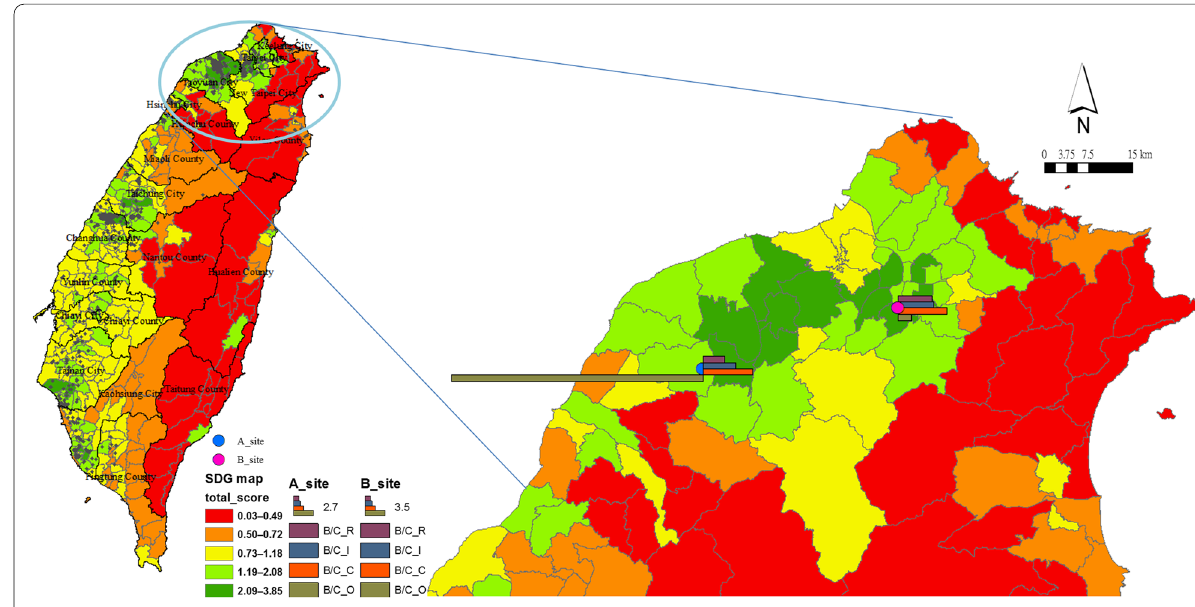
Fig. 6 The benefit‑cost ratios of four scenarios for the two cases in SDGs